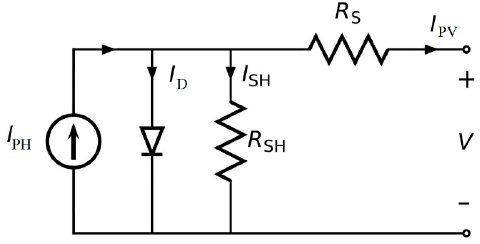
Figure 1. A single-diode model of the photovoltaic (PV) cell.